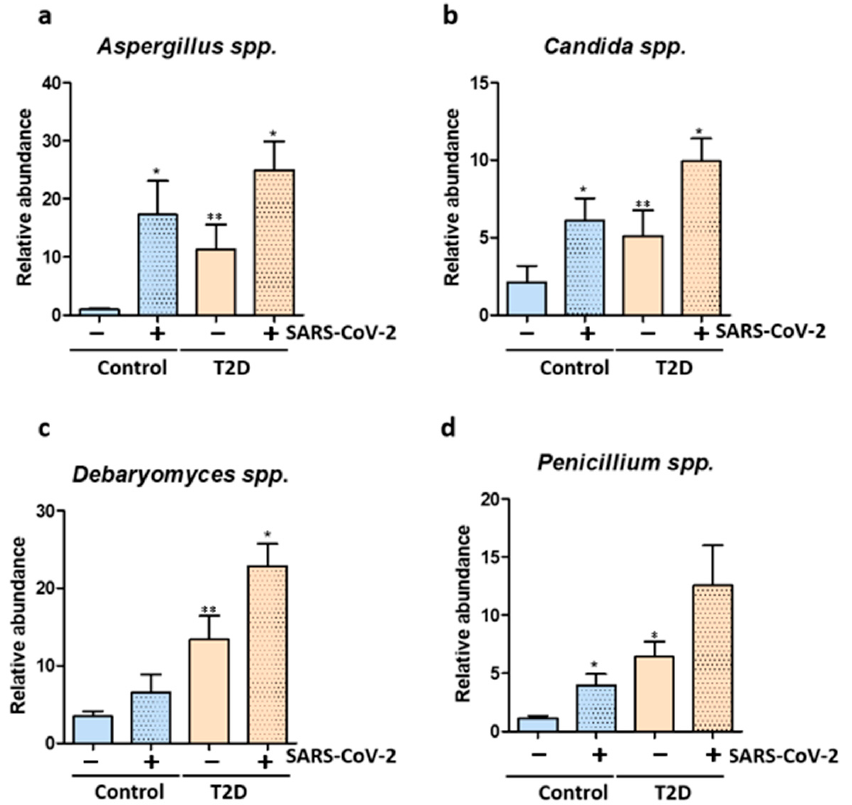
Figure 4. SARS-CoV-2 infection triggers mycobiome changes. ( a ) Relative abundance of Aspergillus spp. quantified using Real time PCR in uninfected and infected T2D patients and healthy controls; ( b ) Relative abundance of Candida spp. quantified using Real time PCR in uninfected and infected T2D patients and healthy controls; ( c ) Relative abundance of Debaryomyces spp. quantified using Real time PCR in uninfected and infected T2D patients and healthy controls; ( d ) Relative abundance of Penicillium spp. quantified using Real time PCR in uninfected and infected T2D patients and healthy controls. Statistical analysis was performed by 1-way ANOVA post hoc Bonferroni test. The statistical significance levels: *, p < 0.05; **, p < 0.01.